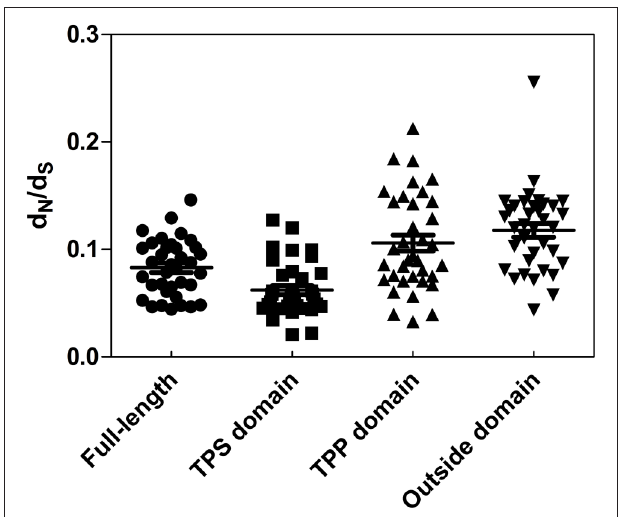
FIGURE 4 | The d N / d S ratios for different regions of lotus TPS proteins.